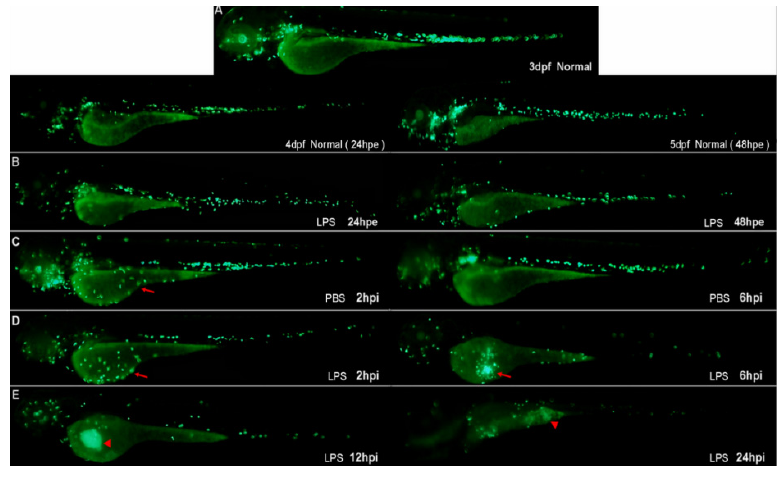
Figure 4. Representative pictures of MPO:GFP lines reveal the LPS-modeled infection process at 3 dpf. ( A ) Normal controls (untreated with any agents or operation); ( B ) larvae immersed in LPS (0.5 mg/mL); ( C ) PBS-injected negative controls; and ( D ) larvae with LPS (0.5 mg/mL) injected into the yolk ( n = 34).